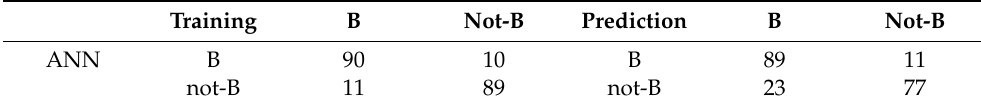
Table 3. Confusion matrix (i.e., percentages of correct assignations as well as misclassifications) for the ANN classification model. True classes are reported in columns, assigned classes are reported in rows.